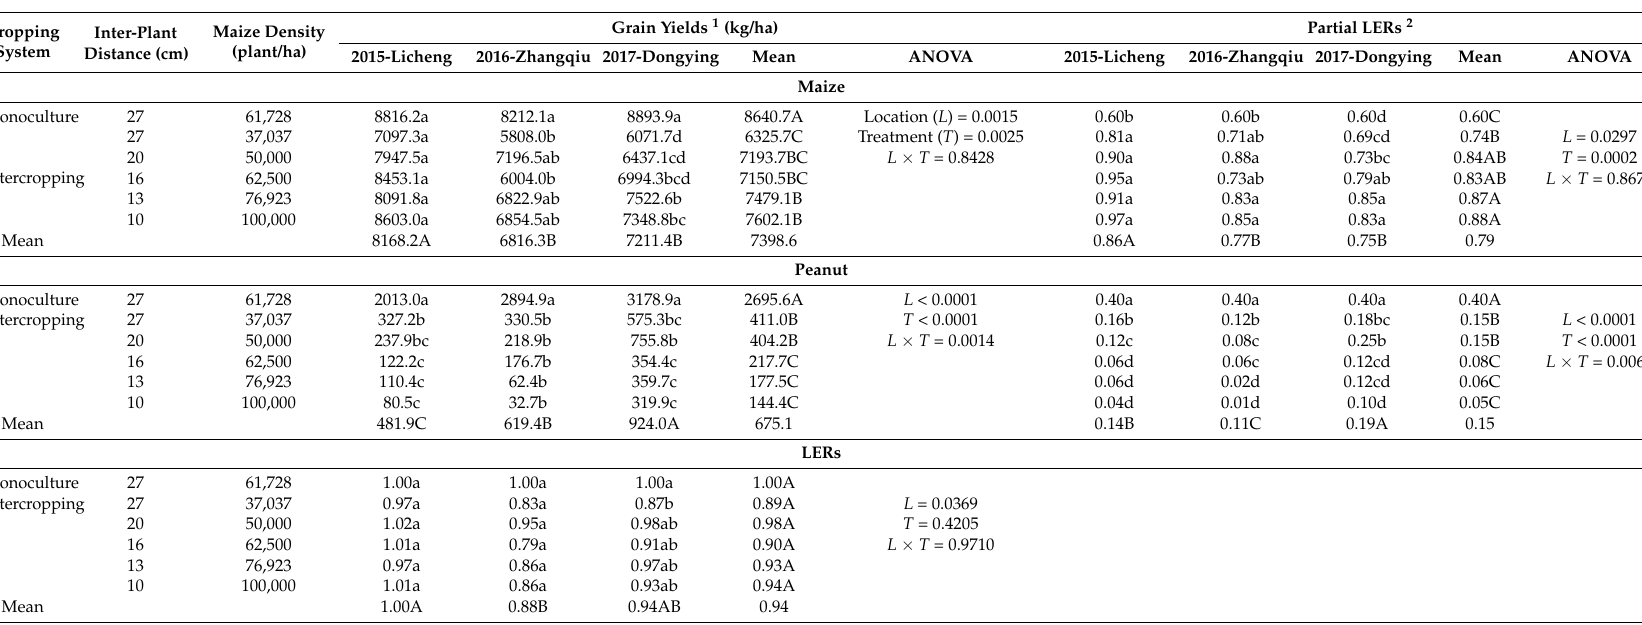
Values are means of three replicates. Values followed by the same lowercase letters at the same experimental location are not significantly different among different treatments at the 5% level by Fisher’s protected LSD (vertical comparison); values followed by the same capital letters are not significantly different among different treatments (vertical comparison) or among different experimental locations/years (horizontal comparison) at the 5% level by Fisher’s protected LSD. ANOVA are the probabilities ( p values) of the source of variation. 1 Grain yields of intercropped maize and peanut were calculated based on total land areas occupied by the whole intercropping system comprised of the two crop species. 2 Partial LERs of mono-cropped maize or peanut were the proportions of land areas occupied by corresponding maize or peanut in the whole intercropping system; partial LERs of intercropped maize or peanut were calculated by grain yields of intercropped maize or peanut dividing by grain yields of mono-cropped maize at the maize inter-plant distance of 27 cm or mono-cropped